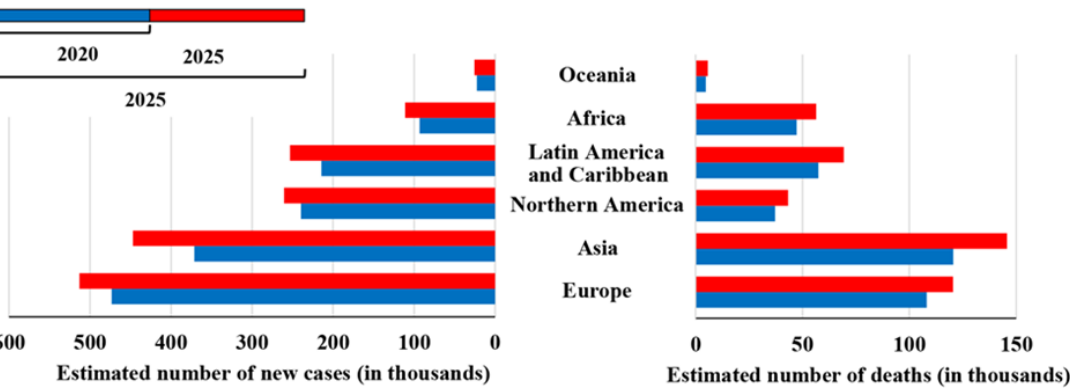
Figure 2. Estimated number of new cases and deaths from prostate cancer from 2020 to 2025. Source: GLOBOCAN 2020 [1,5].